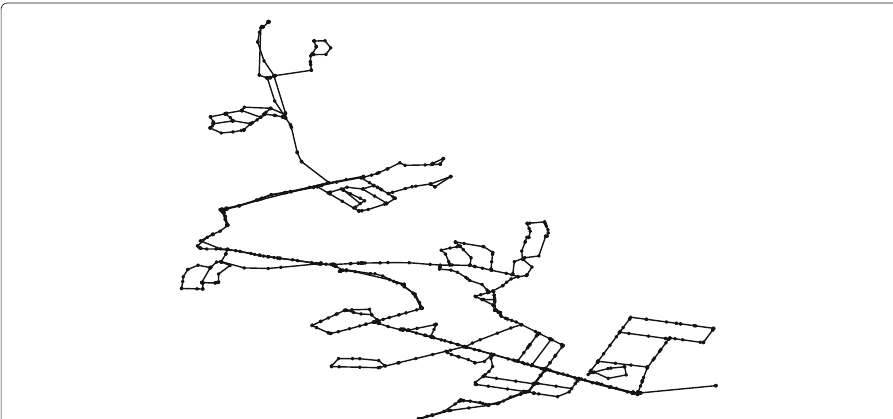
Fig. 7 Core model of BWFL. The core model of BWFL represents the network after removal of the forest links